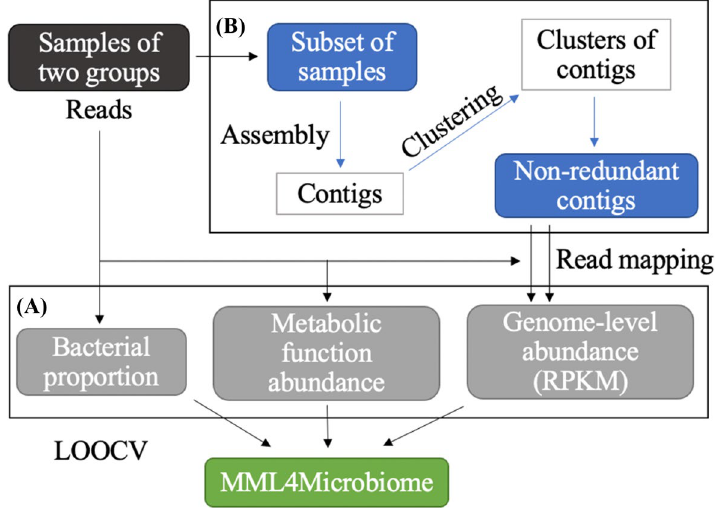
Figure 1. Schematic diagram of MDL4Microbiome. (A) Three methods were used to generate different types of features, viz., conventional taxonomic profiles, metabolic functional features, and genome-level abundance. Different features are fed into the multimodal deep learning model. The model was evaluated by the leave-one- out cross-validation method. (B) Specific steps of extracting non-redundant contigs of known and unknown microorganisms. A subset of samples is selected randomly. After contigs are assembled with the reads of the selected samples, they are clustered to collect a set of non-redundant representative contigs. Entire sample reads are mapped to non-redundant contigs to measure the relative abundance of genomic fragments.